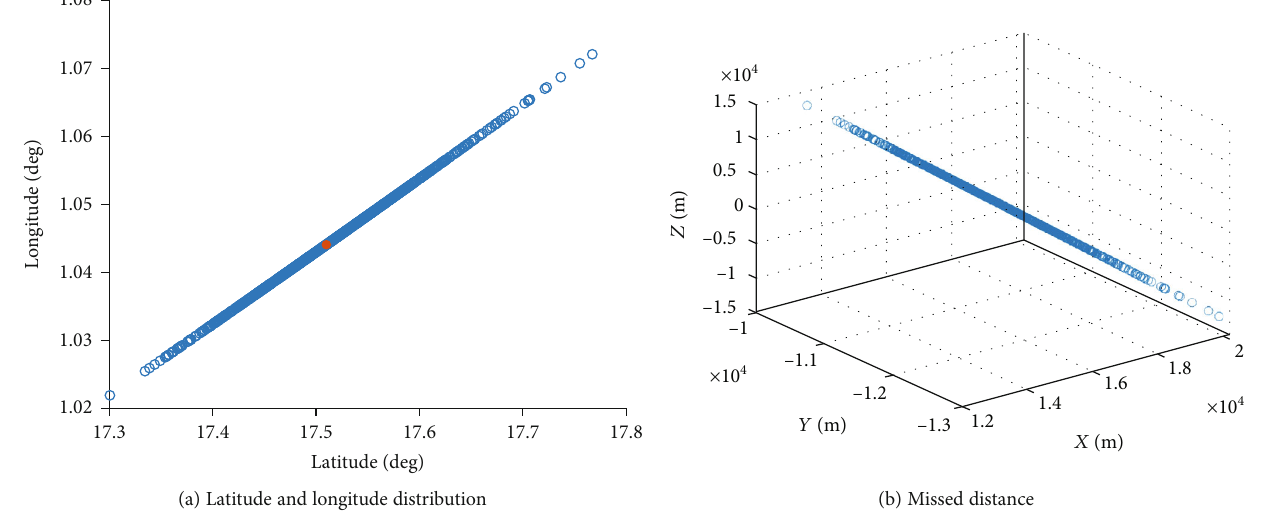
Figure 8: Monte Carlo simulation of nonlinear application in the Mars model varying initial